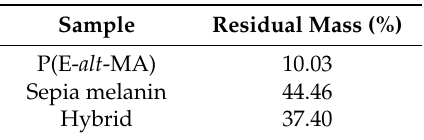
Figure 3. ( a ) Summary of the thermogravimetric plots; ( b ) TGA and DTA analysis of the sepia melanin-P(E- alt -MA) hybrid; ( c ) TGA and DTA analysis of P(E- alt -MA); ( d ) TGA and DTA analysis of sepia melanin. Table 2. Residual mass values obtained from TGA.